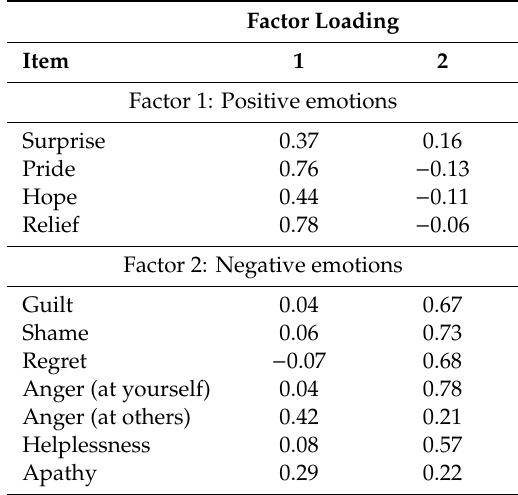
Table 4. Exploratory Factor Analysis (EFA) Results for Procrastination Emotions.